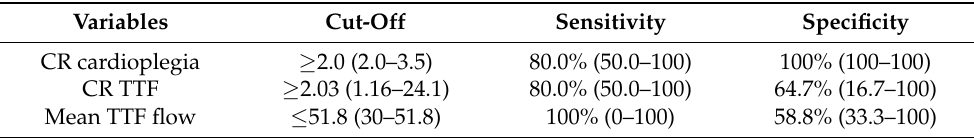
Figure 3. Discriminant ability of different parameters to predict early graft failure. TTF: transit time flowmetry; PI: pulsatility index. ROC (receiver operative characteristic). Table 5. Bootstrapped cut-off points (with 95% confidence intervals) of transit time flow derived parameters for predictability of 1-year graft occlusion.